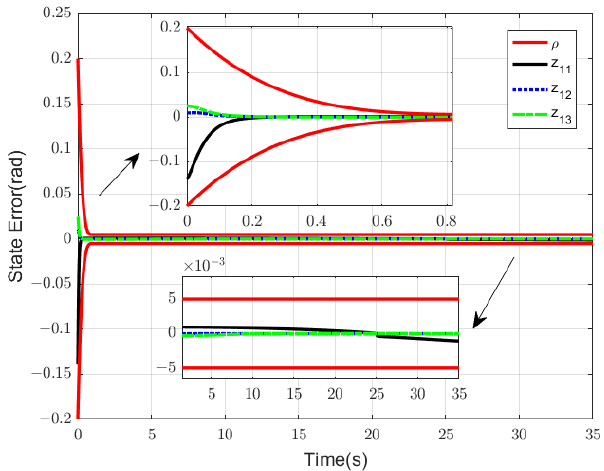
Figure 9. Attitude tracking errors of σ , β , α .